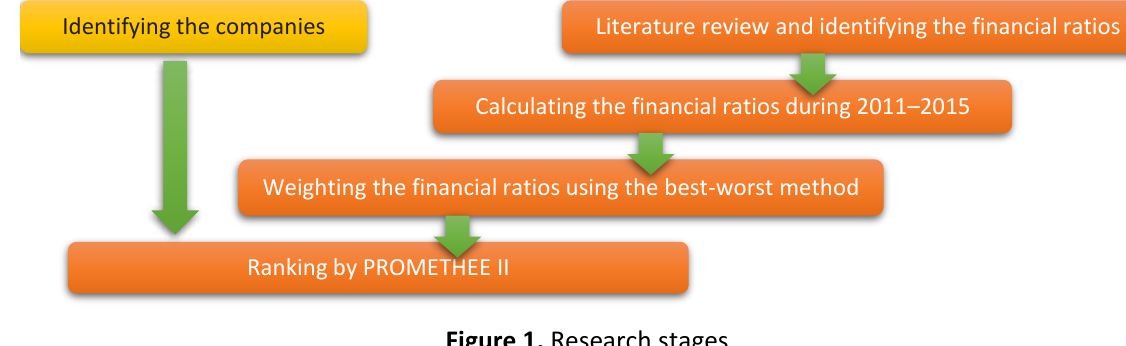
Figure 1. Research